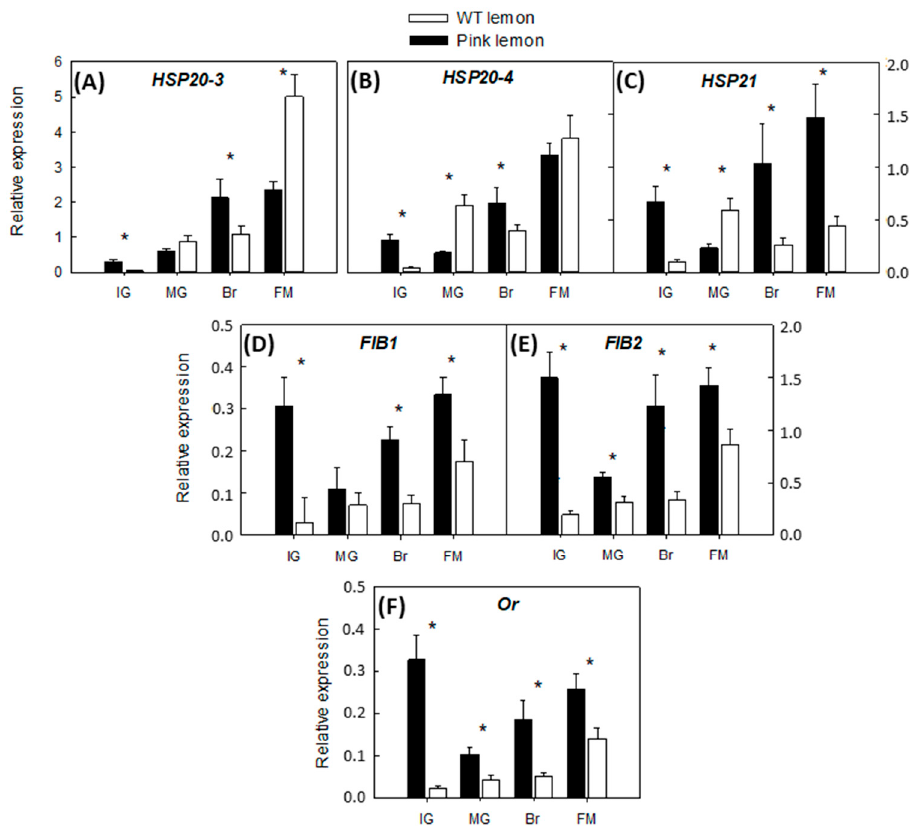
Figure 6. Changes in the expression of genes of carotenoid-associated proteins: HSP20-3 , heat shock protein 20-3 ( A ); HSP20-4 , heat shock protein 20-4 ( B ); HSP21 , heat shock protein 21 ( C ); FIB1 , fibrillin 1 ( D ); FIB2 , fibrillin 2 ( E ); Or , orange protein gene ( F ), in the pulp of the PL and WT lemon fruit at four developmental stages: IG (immature green), MG (mature green), BR (breaker), FM (fully mature). Asterisks indicate significant differences between genotypes for each developmental stage ( p < 0.01) by one-way ANOVA ( p < 0.01).